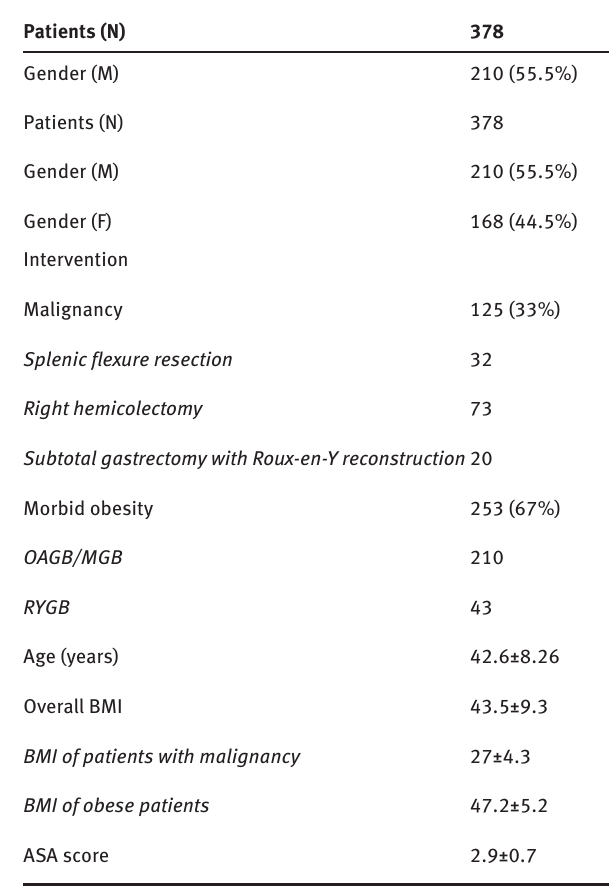
Table 1: Patients’ and diseases’